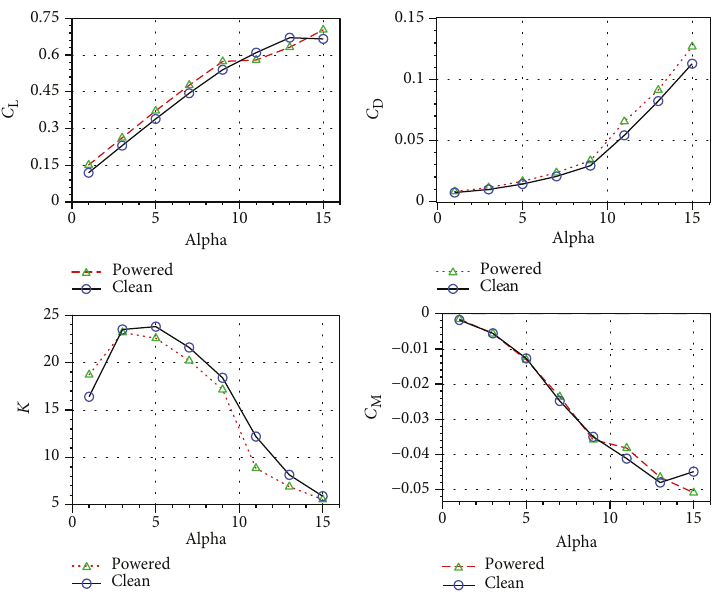
Figure 11: Comparison of aerodynamic forces for the clean and powered con fi gurations at low speed.